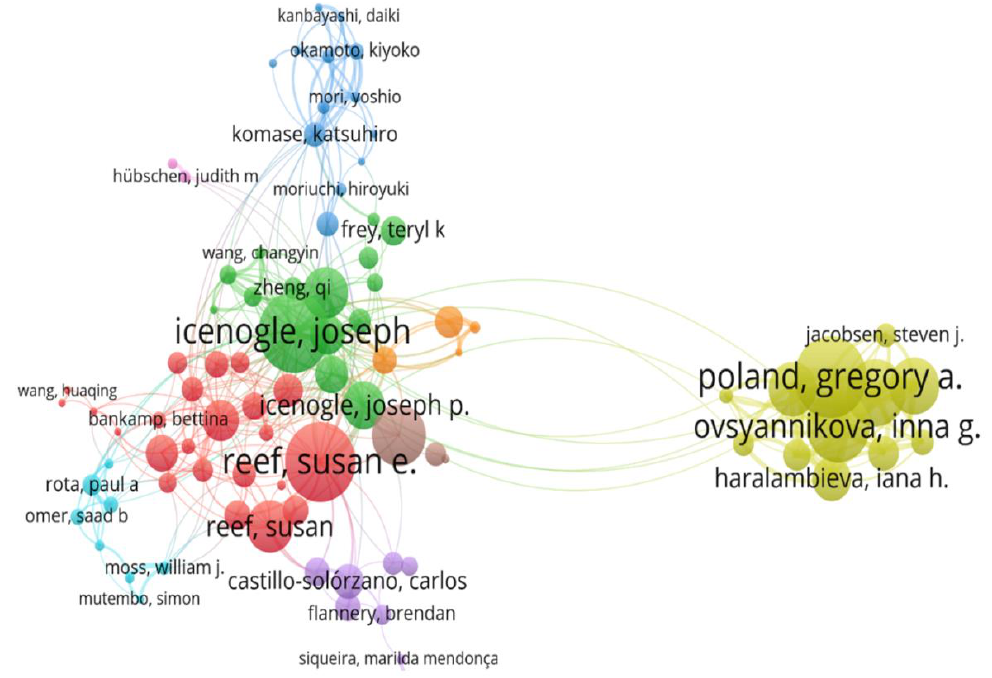
Figure 5. Outstanding authors of rubella virus research publications.